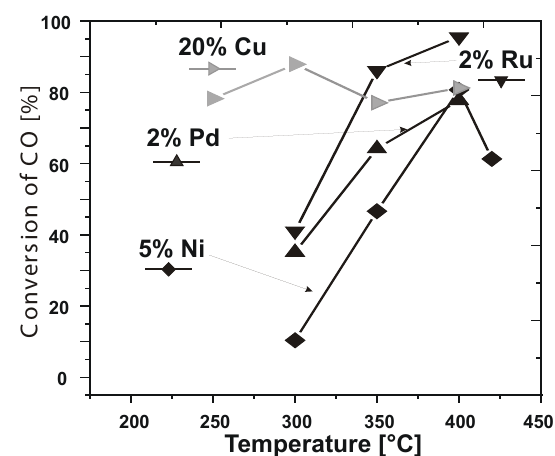
Figure 4. Activity tests in WGS reaction of various transition metal catalysts after calcination at 400°C.